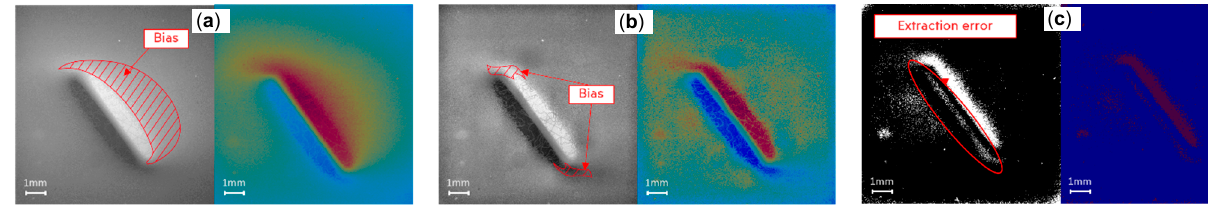
Figure 13. Bias analysis: ( a ) raw cut dataset, ( b ) CLAHE dataset, and ( c ) extraction dataset.